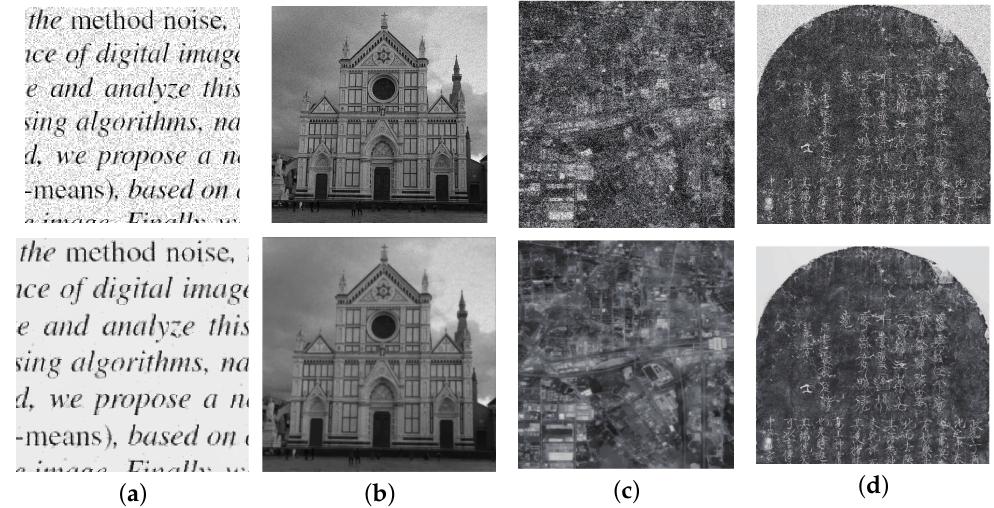
Figure 2. The first row is the initial image with 10% speckle noise and the second row is the obtained smoothing results. From ( a – d ), the image types are text image, photo taken by camera, remote sensing image, and scanning image